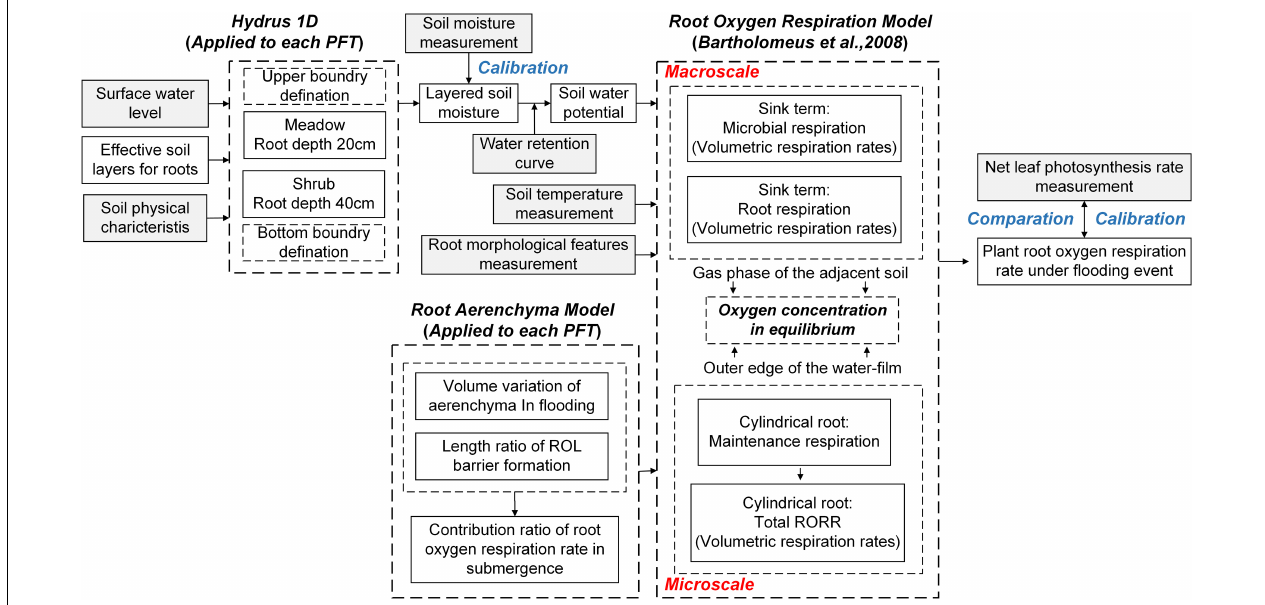
FIGURE 2 | The model framework of the present study (building process of the eco-hydrological model). Gray-colored boxes underlines the data from field